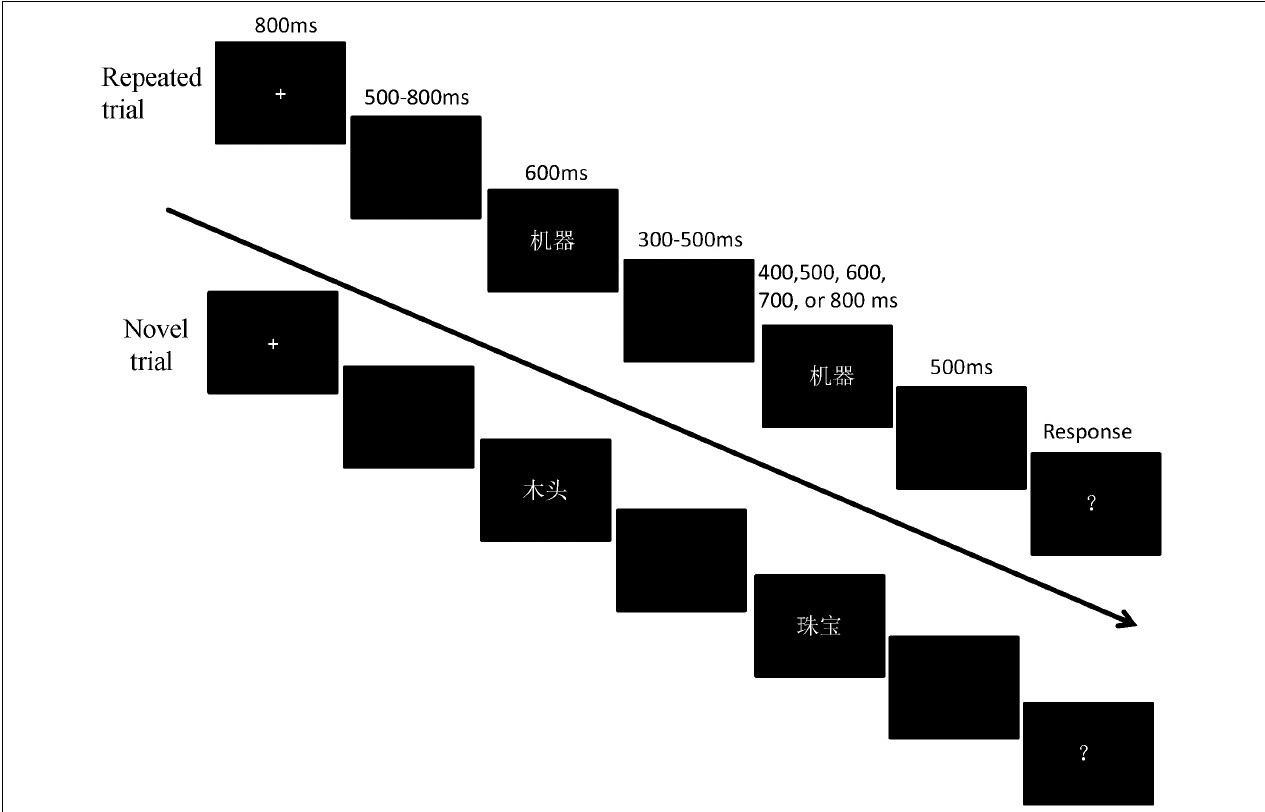
FIGURE 1 | Schematic illustrations of stimuli presentation in Experiment 1. In the repeated trials, the standard and comparison words/pseudowords were identical (e.g., /ji 1 qi 4/, meaning “machine”). In novel trials, the standard and comparison words/pseudowords were different (e.g., the standard: /mu 4 tou 1/, meaning “wood”; the comparison: /zhu 1 bao 3/, meaning